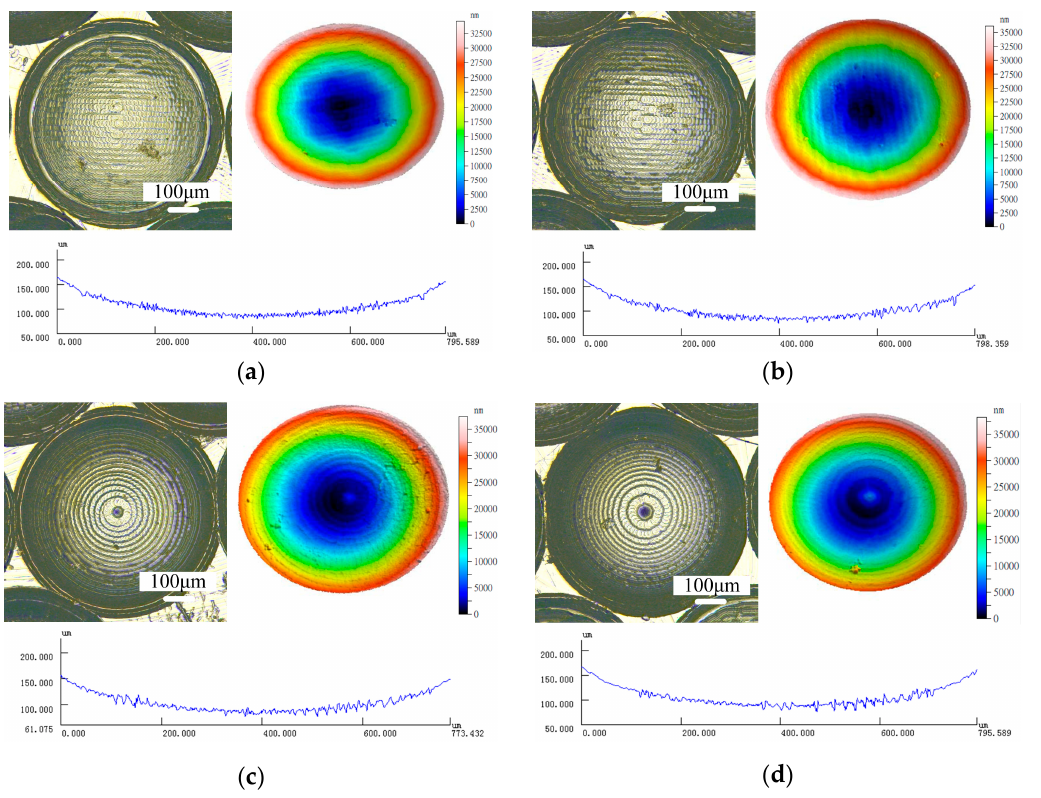
Figure 4. Surface morphology of the machined micro-lens mold under different strategies ( n = 10,000 r/min, f = 45 mm/min, L w = 0.02 mm). ( a ) Single-direction raster; ( b ) raster; ( c ) 3D offset spiral; and ( d ) equal height finish.